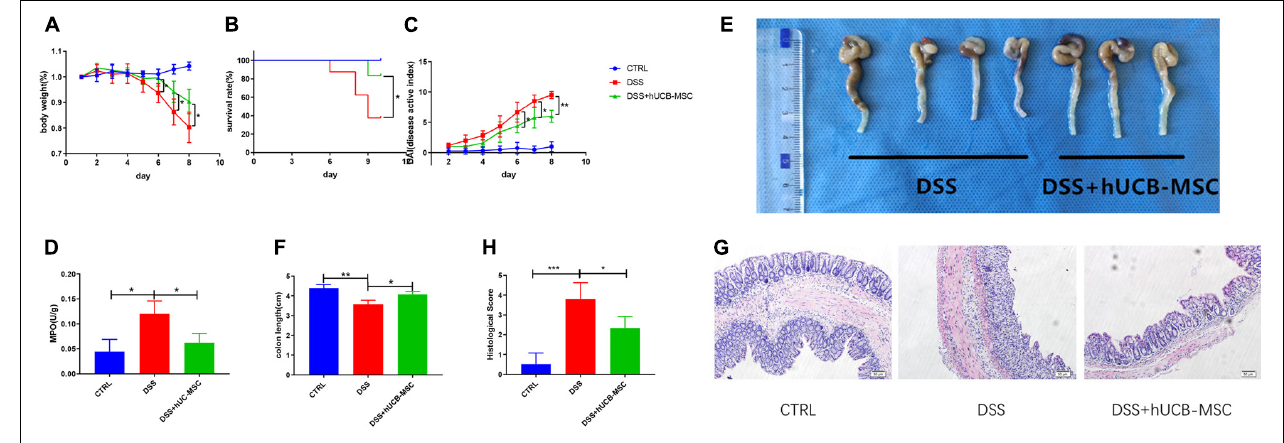
FIGURE 4 | Treatment with hUCB-MSCs protects against DSS-induced acute colitis. Weight loss (A) , survival rate (B) , and disease activity index (C) were determined daily. MPO activity in colonic protein extracts were used to show neutrophil infiltration (D) . Colon length (E,F) and histopathological signs (G,H) were determined on day 10. The control group used tap water. n = 6–8 mice per group. * p < 0.05, ** p < 0.01, *** p < 0.001. The magnification of HE staining images is 10 × 10.